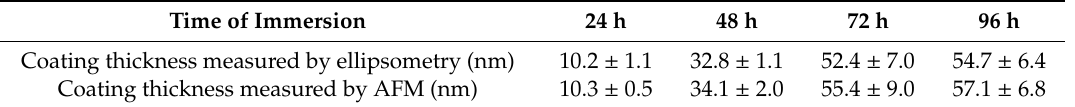
Figure 3. SEM micrographs showing ( a ) the Ti6Al4V surface with a polydopamine (pDA) coating (left) and uncoated (right) at a magnification of 1000×, as well as ( b ) the pDA coating at 100,000× magnification. Table 4. Polydopamine coating thickness as measured by ellipsometry and Atomic Force M.icroscopy